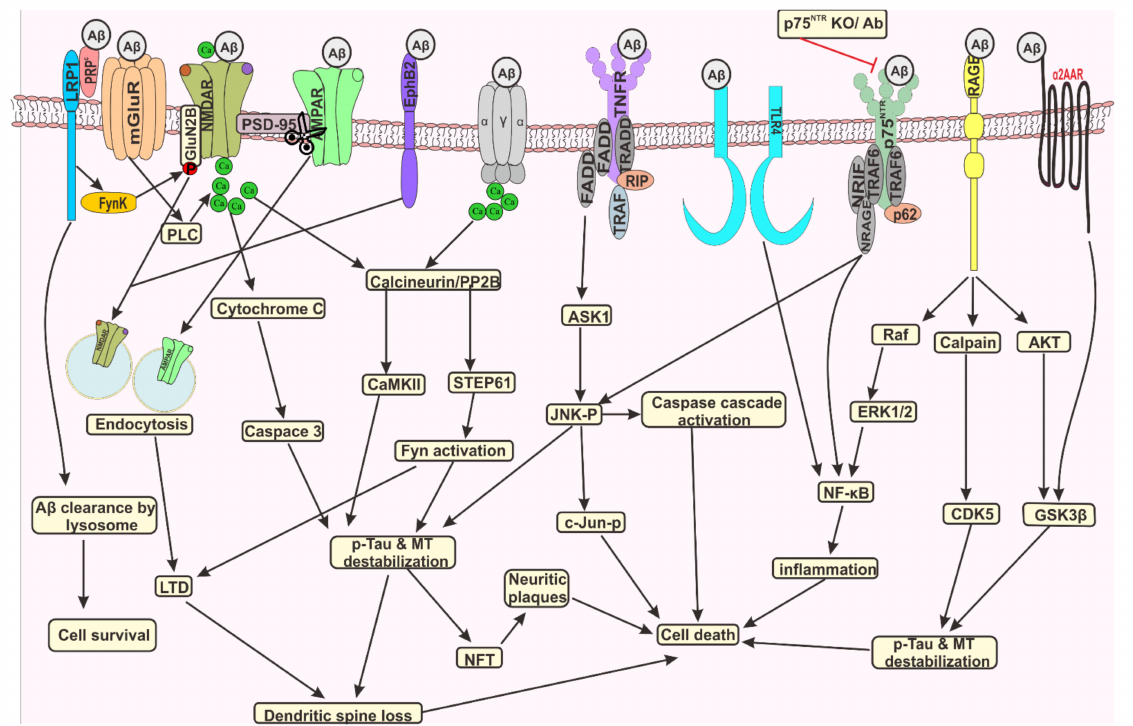
Figure 2. Signaling of A β in memory impairment, tau hyperphosphorylation and cell death in AD: LRP1 receptor facilitates the A β clearances as well activates the FynK. A β binding with receptors such as mGluR, NMDAR, AMPAR, EphB2 triggers the LTD via NMDAR and AMPAR surface removal. In other hand, prolonged activation of NMDAR elevates the intracellular Ca 2+ level which increases caspase 3. The inflammation is induced by the activation of NF- κ B upon A β mediated activation of TLR-4, p75NTR and RAGE receptors. The tau hyperphosphorylation is induced by several kinases including GSK3 β , CDK5, JNK, FynK upon A β binding with most of the receptors which destabilizes microtubules, forms the NFT and neurotic plaques. The LTD, NFT, inflammation, increased caspase cascade leads to dendritic spine loss and cell